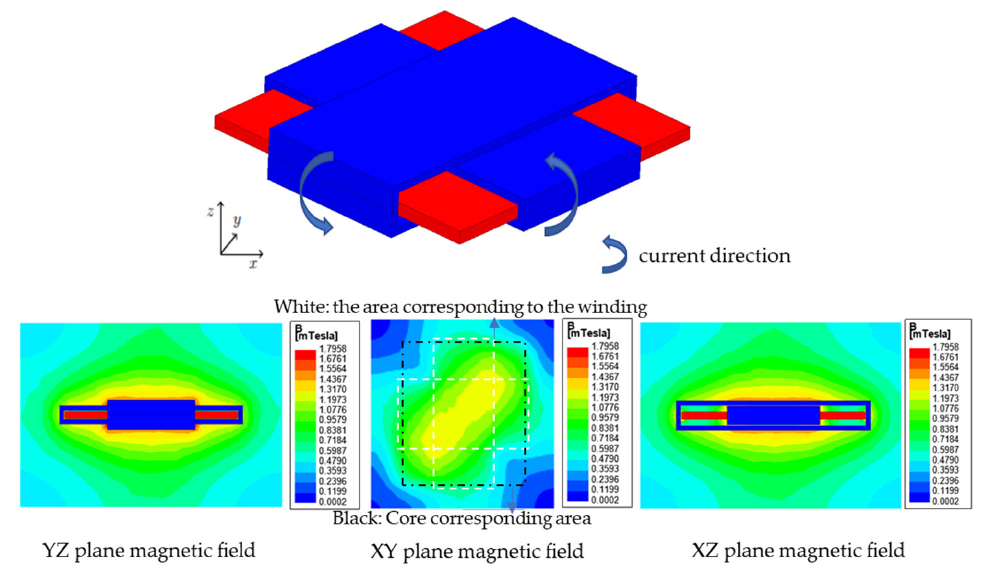
Figure 5. Schematic diagram of the cross-coupled coil structure.